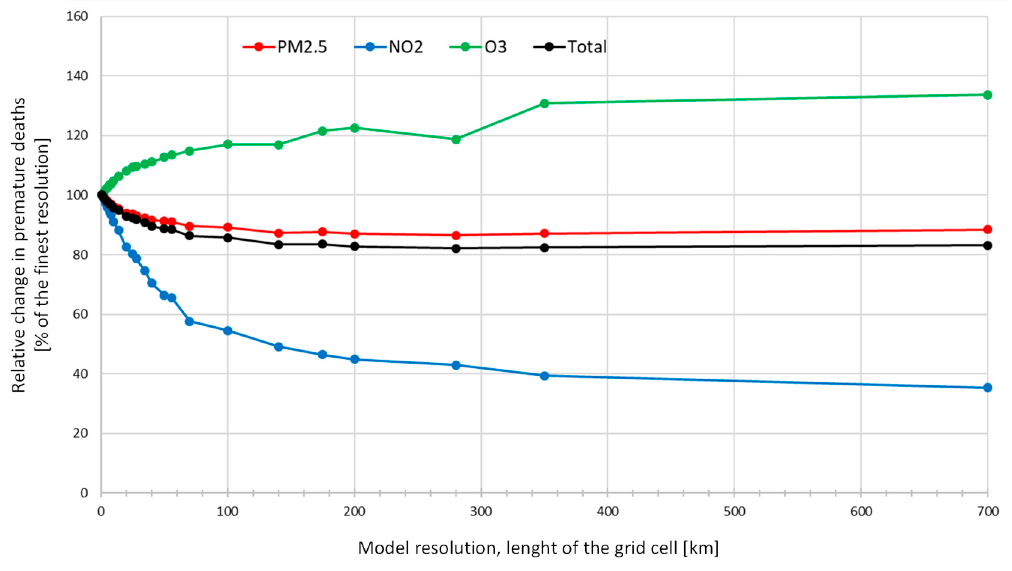
Figure 4. Relative change in number of premature deaths attributable to air pollution exposure as function of spatial resolution in percentage from the highest (1 km × 1 km) to the of the coarsest resolution (700 km × 700 km), calculated by the UBM/EVA model system for PM 2.5 , NO 2 , O 3 and total.